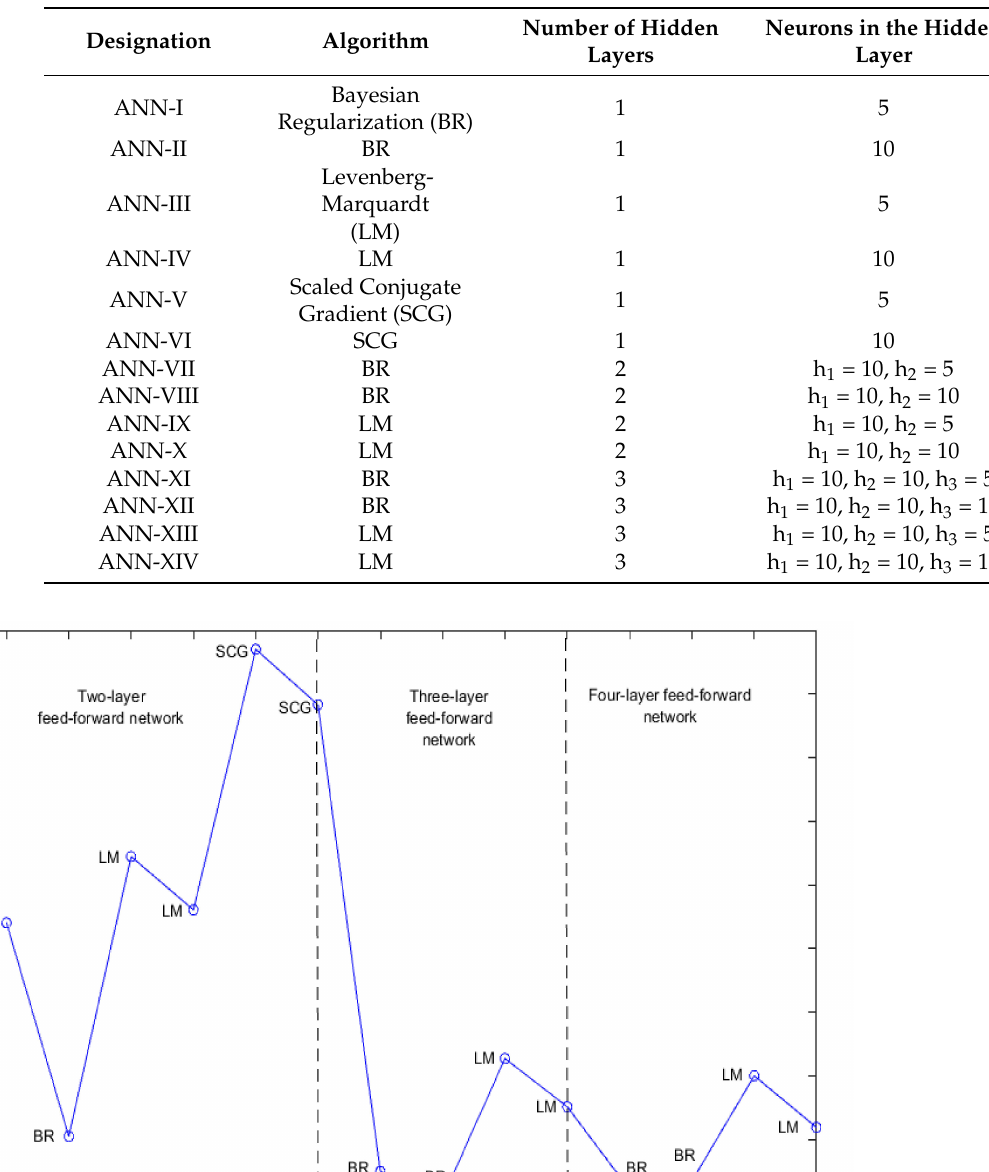
Table 5. Multilayer feedforward neural network models for the prediction of Compressive Strength of geopolymer concrete.